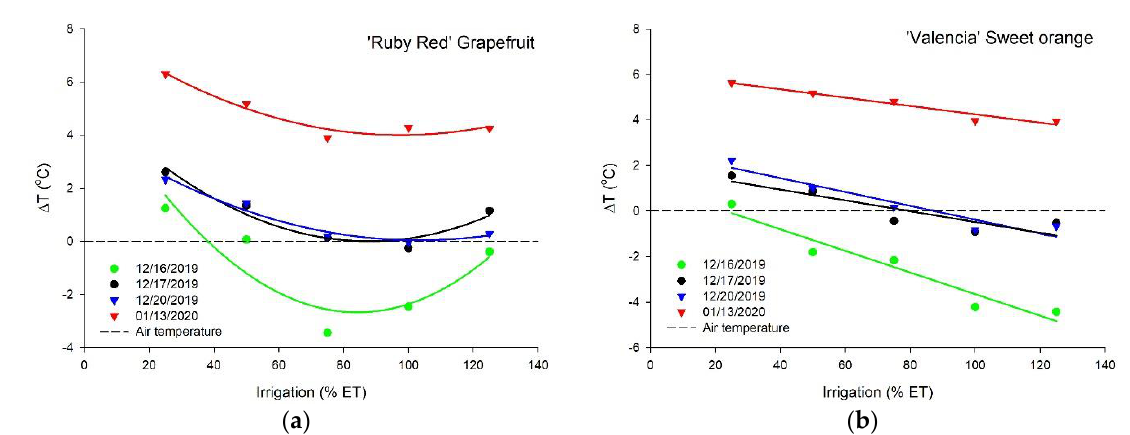
Figure 5. Temperature difference (∆T) between the plants and the air of ‘Ruby Red’ grapefruit ( a ) and ‘Valencia’ sweet orange ( b ) under increasing levels of irrigation based on crop evapotranspiration (ETc). Polynomial and linear models adjusted by regression using data from 5 replications ( n = 5). Each data point is an average of 5 replications.